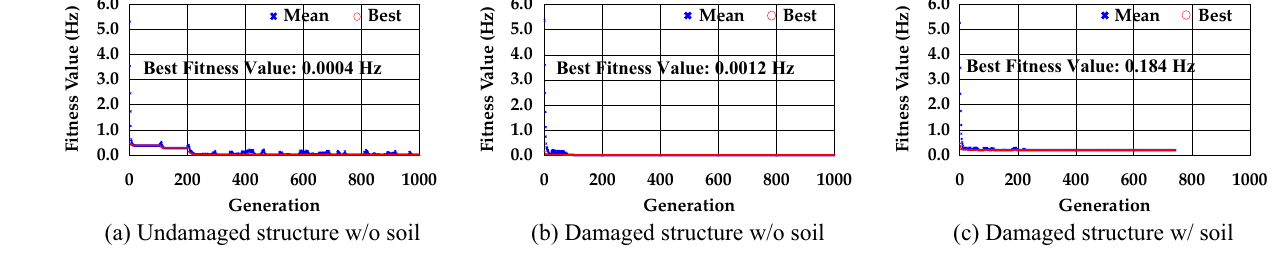
Figure 8. Fitness values at each generation.